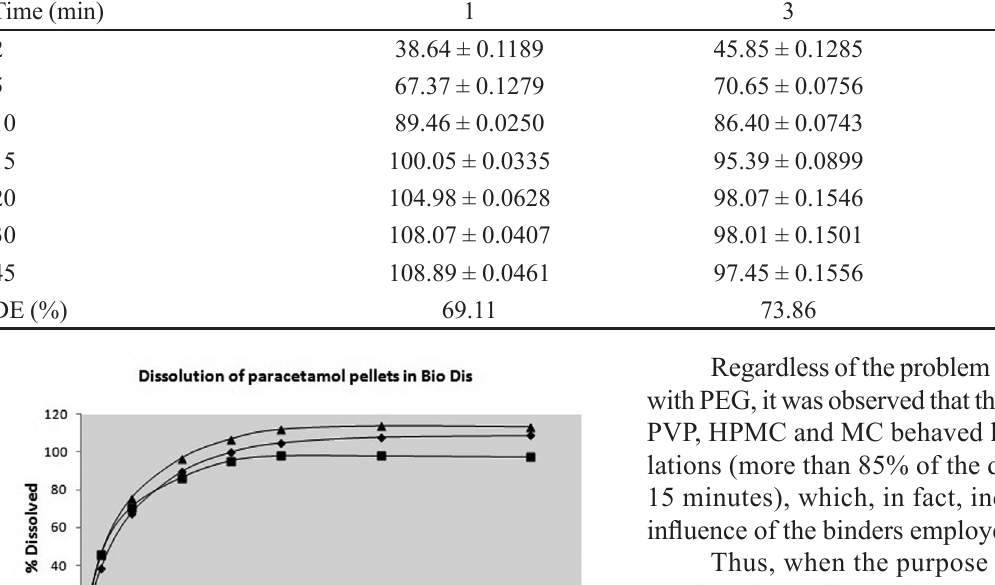
TABLE V - The dissolved percentage (± standard-deviation) obtained for the formulations containing PVP (1), HPMC (3) and MC (4) and their respective dissolution efficiency values (DE), in Bio-Dis. n = 3 Time (min)